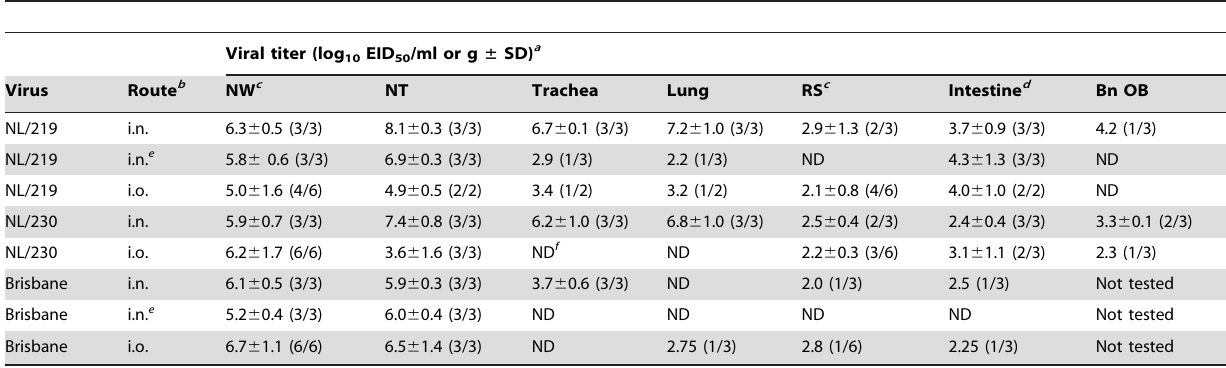
Table 3. Comparative viral pathogenesis between intranasal and ocular inoculation day 3 p.i. in extra-ocular